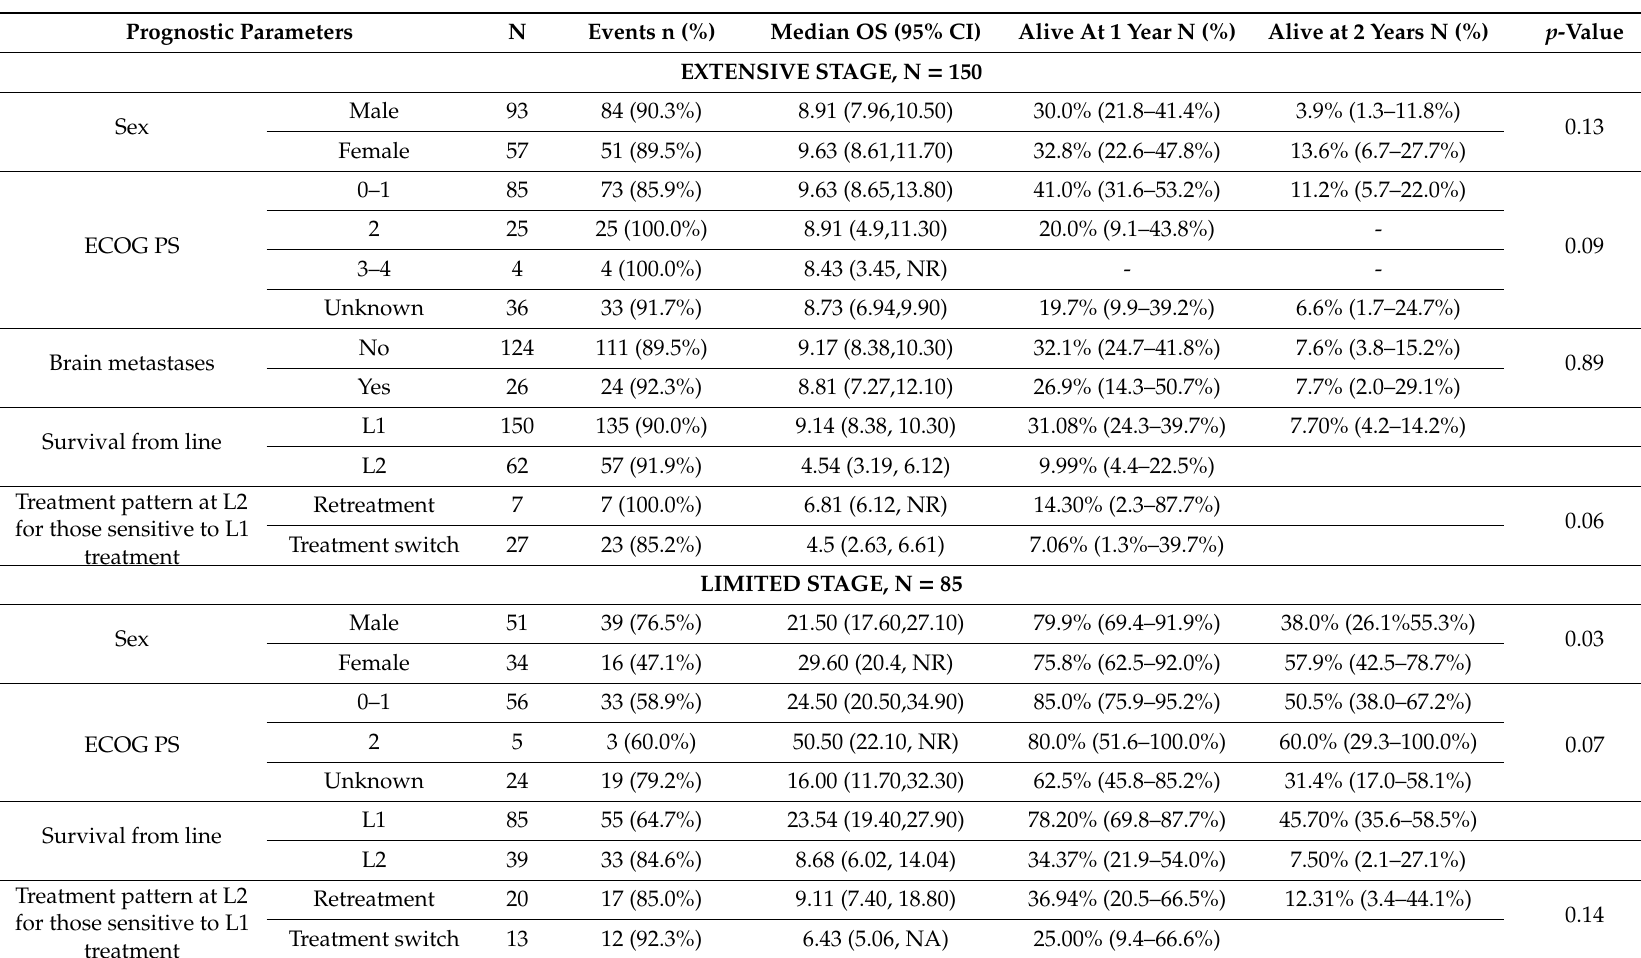
Table 2. Univariate analysis for prognostic parameters for overall survival (survival from initiation of L1 treatment, unless otherwise stated; log-rank test). Prognostic